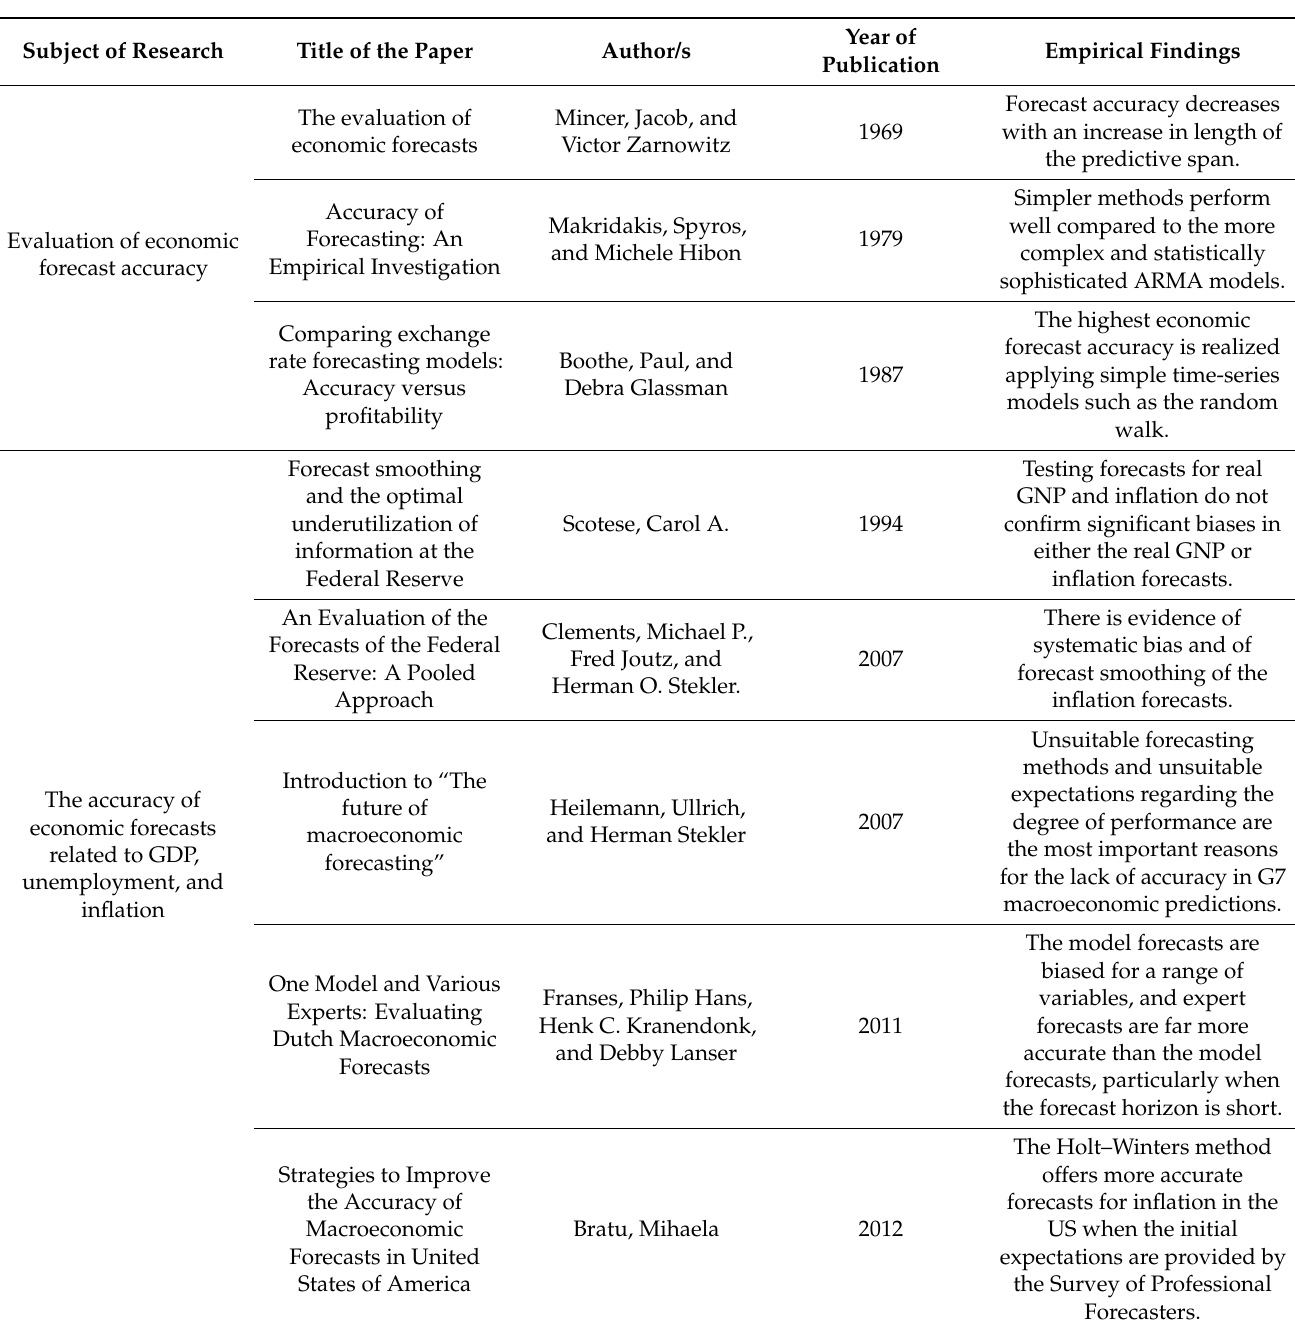
Table 8. Classification of Empirical